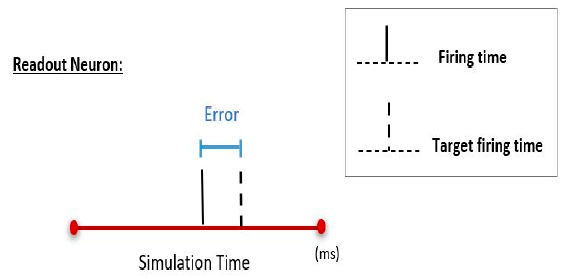
Figure 4. Generic scheme of readout neuron.